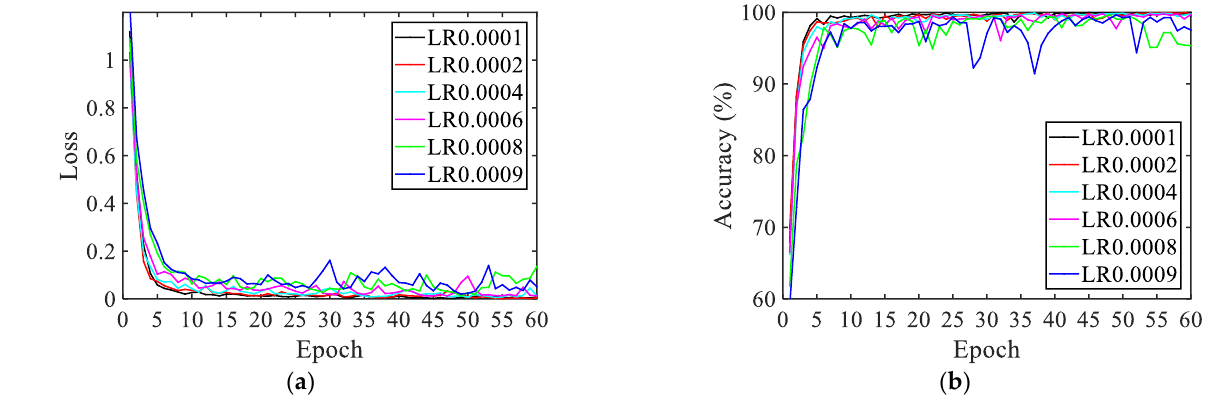
Figure 11. The curves of loss and test accuracy. ( a ) Loss , ( b ) accuracy .